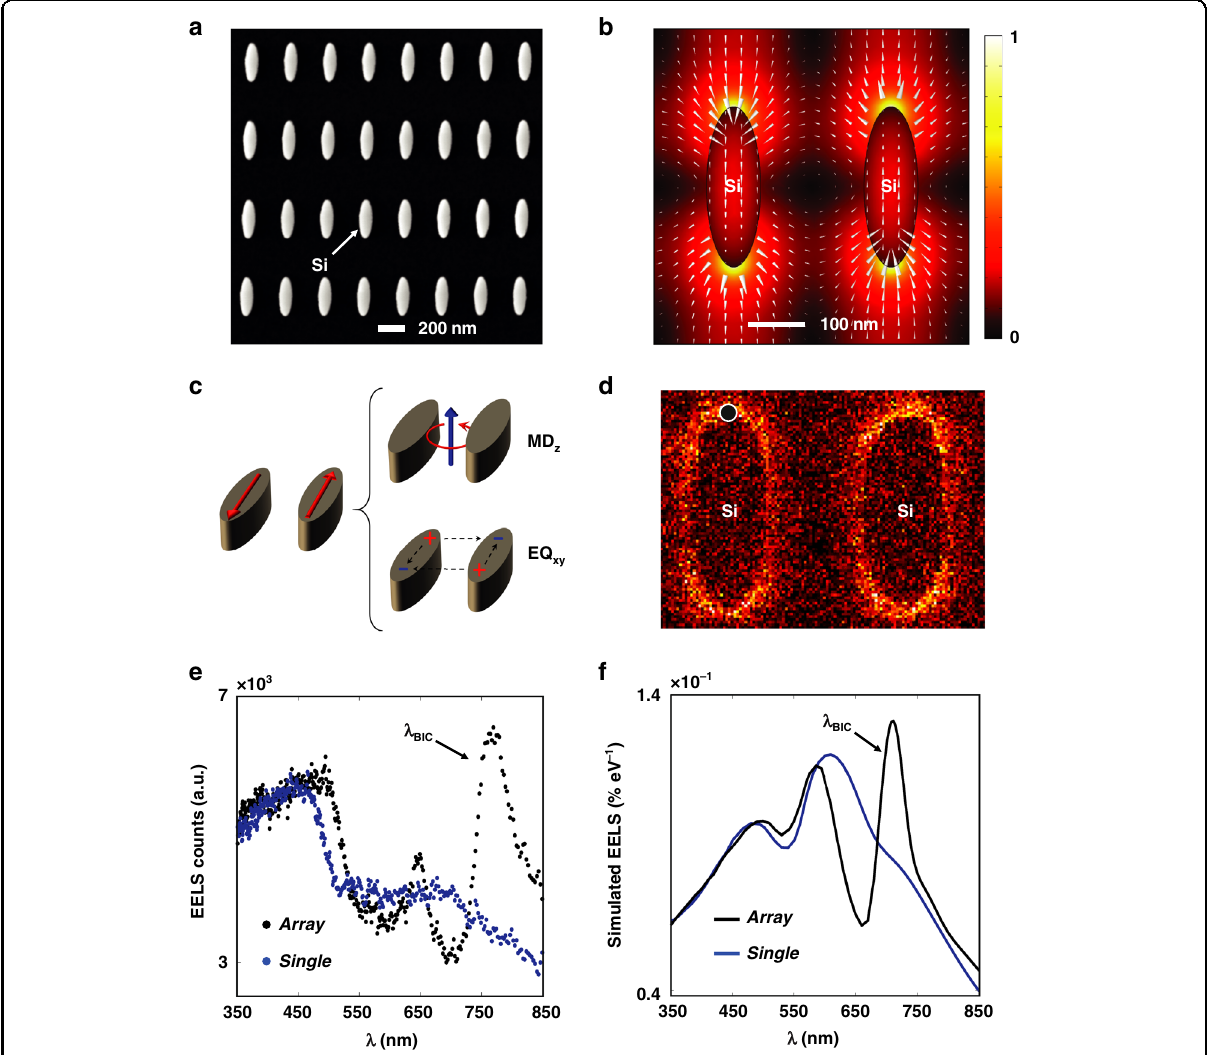
Fig. 2 Probing of a “ true ” BIC resonance mode by Electron Energy Loss Spectroscopy. a STEM annular dark- fi eld image of a silicon nanoantenna array with elliptic cylinders aligned at a tilt angle θ = 90°. b Simulated near- fi eld mode pattern of the “ true ” BIC mode, with arrows indicating the electric fi eld direction; their length being proportional to the amplitude. c Schematic of the multipole moments comprising the “ true ” BIC mode: the z -polarized magnetic dipole (MD z ) and the electric quadrupole (EQ xy ). d Experimental EELS map of the elliptic cylinder nanoantenna array with the “ true ” BIC mode resembling the E- fi eld maps in ( b ). e EELS spectrum (black color) as measured at the position near the tip of the ellipse as indicated in ( d ) demonstrating the excitation of the “ true ” BIC mode. For benchmarking, the EELS spectrum measured from an isolated single antenna element of the same size (blue color) clearly shows the missing peak associated with the BIC mode. More information about the single antenna measurements can be found in the Fig. S3. f FEM-simulated EELS spectra for the nanoantenna array (black), showing a BIC resonance, and for a single antenna element (blue), showing no BIC